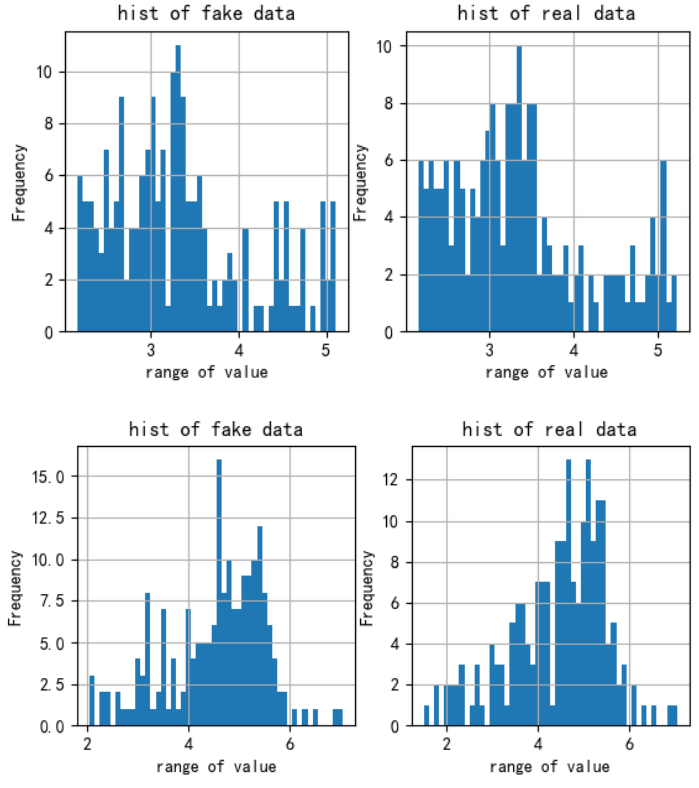
Figure 6. Frequency hist of imputation results and real-time series on electrity dataset.